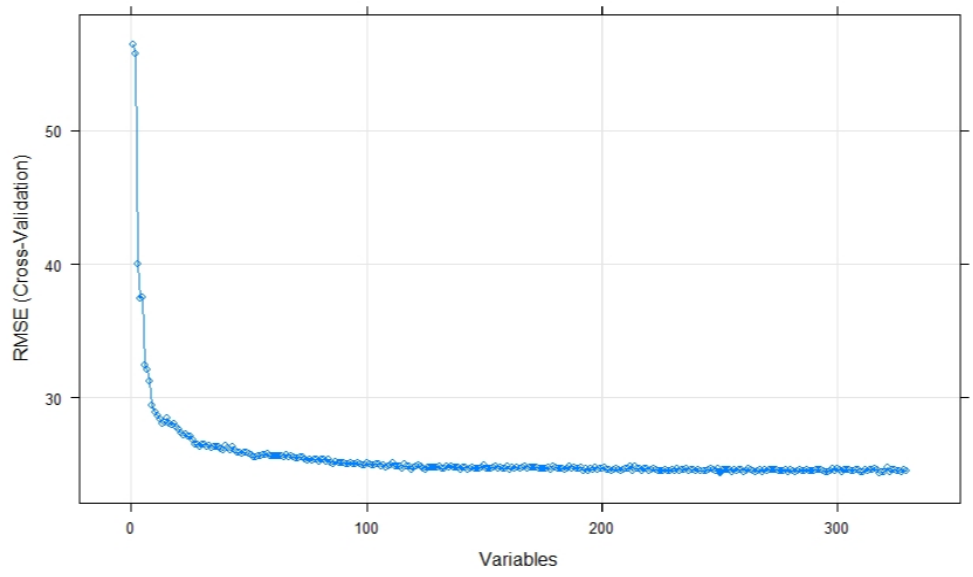
Figure 3. RMSE Changes as a Result of Adding Additional Ranked Predictors. Source: Authors’ calculation in R studio. Table 2. RMSE and MAE after the 29th Predictor.